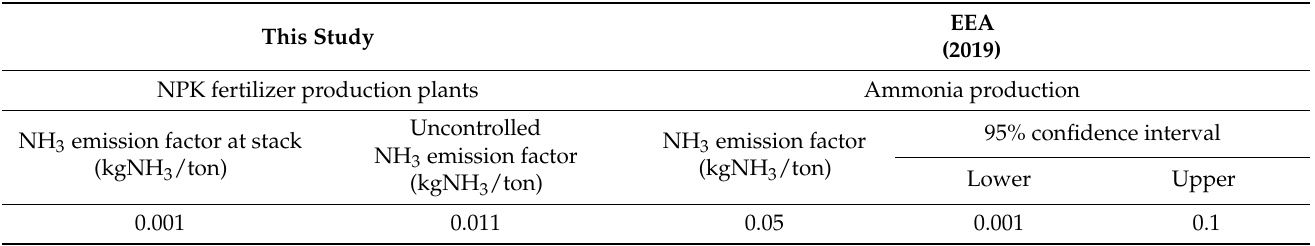
Table 8. Comparison of NH 3 emission factor in similar